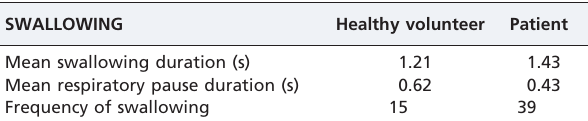
Table 1 - Mean duration of swallowing parameters (volitional, 3 mL, 5 mL, and 10